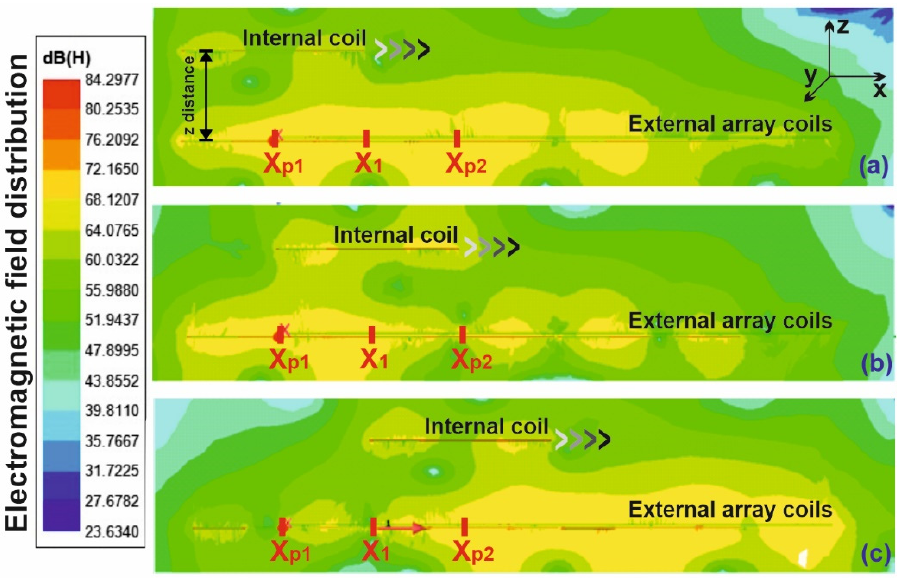
Figure 10. Electromagnetic field distribution over internal coil movement from ( a ) top of first external coil, ( b ) border of two neighborhood coils with a 50% overlapped coil, and ( c ) top of next neighboring external coil.